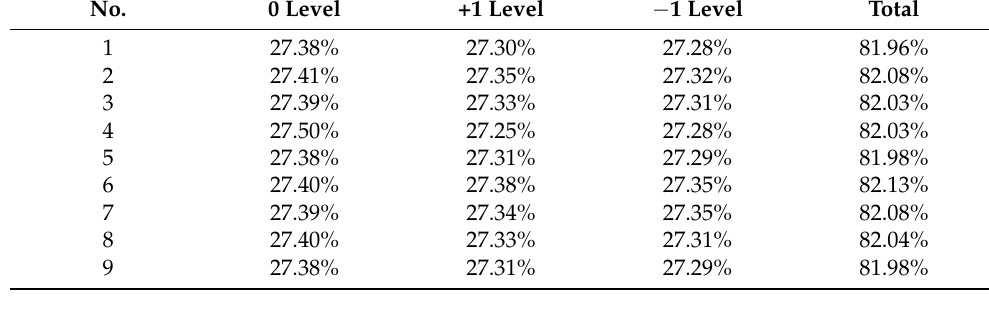
Figure 11. ( a ) Single-wavelength diffraction efficiency test optical path. ( b ) Distribution of sampling points for aberrated off-axis Fresnel waveband diffraction efficiency test. Table 3. Test results (diffraction efficiency).